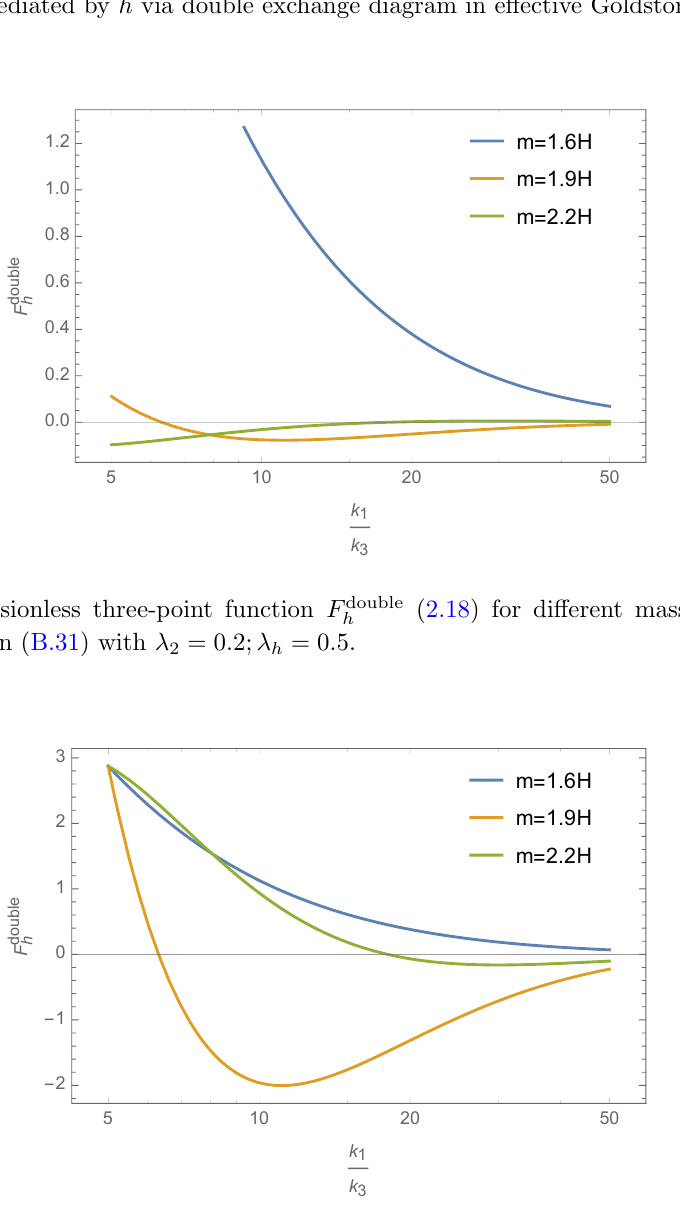
Figure 10 . Shape sensitivity of F double to m h . We have chosen three plausible sets of parameters h for which F double agree at the (cid:12)ducial ratio k 1 = 5. This illustrates our ability to discriminate h k 3 among di(cid:11)erent masses.